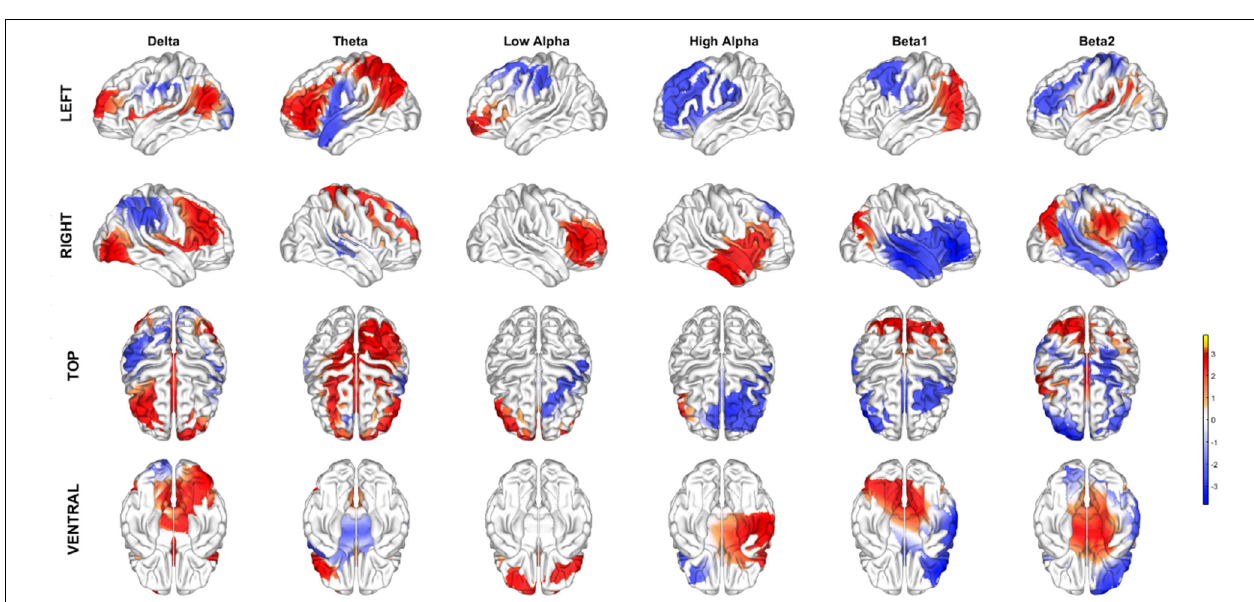
FIGURE 3 | Topographic maps of the sources corresponding to the loadings of the qEEG latent variable for each classical frequency bands.